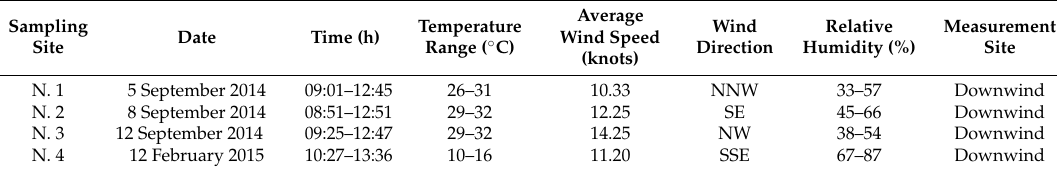
Table 2. Measurement times and meteorological data during each sampling (inside the